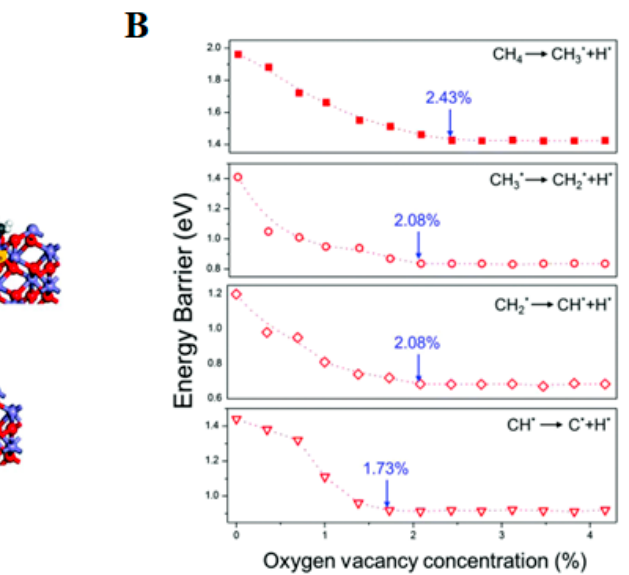
Figure 8. ( A ) Mechanism for CH 4 partial oxidation over α -Fe 2 O 3 (001) surface with oxygen vacancies. Inset of the reaction loop is the activation barrier (eV) for each elementary step. V O represents the surface oxygen vacancy. ( B ) The correlation between activation energy of C–H bond and the oxygen vacancy concentration of α -Fe 2 O 3 (001) surface. Reprinted with permission from Ref. [103], copyright 2016, Royal Society of Chemistry.